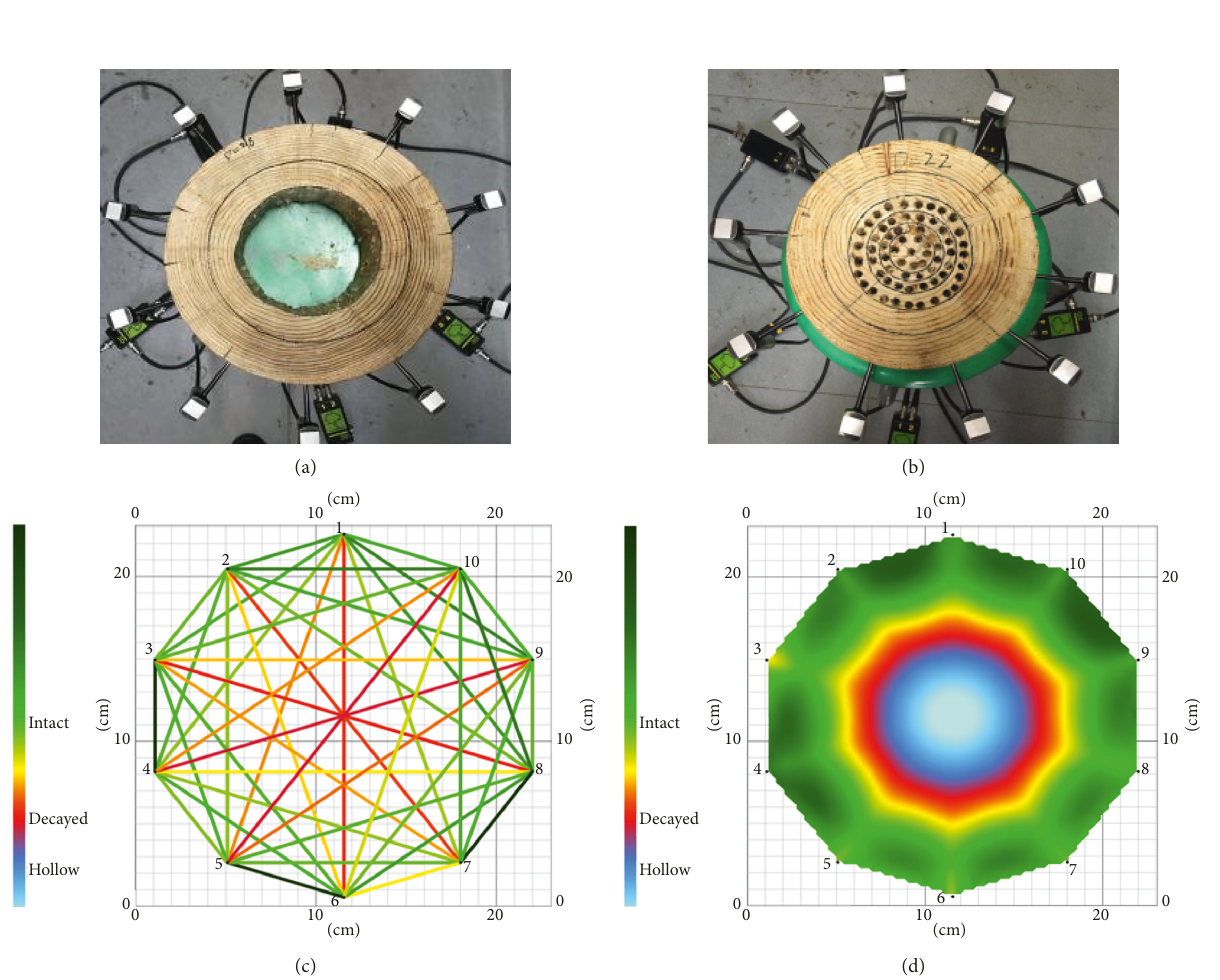
Figure 5: Stress wave tests: (a) hollow; (b) insect attacks; (c) wave velocity diagram; (d) two-dimensional